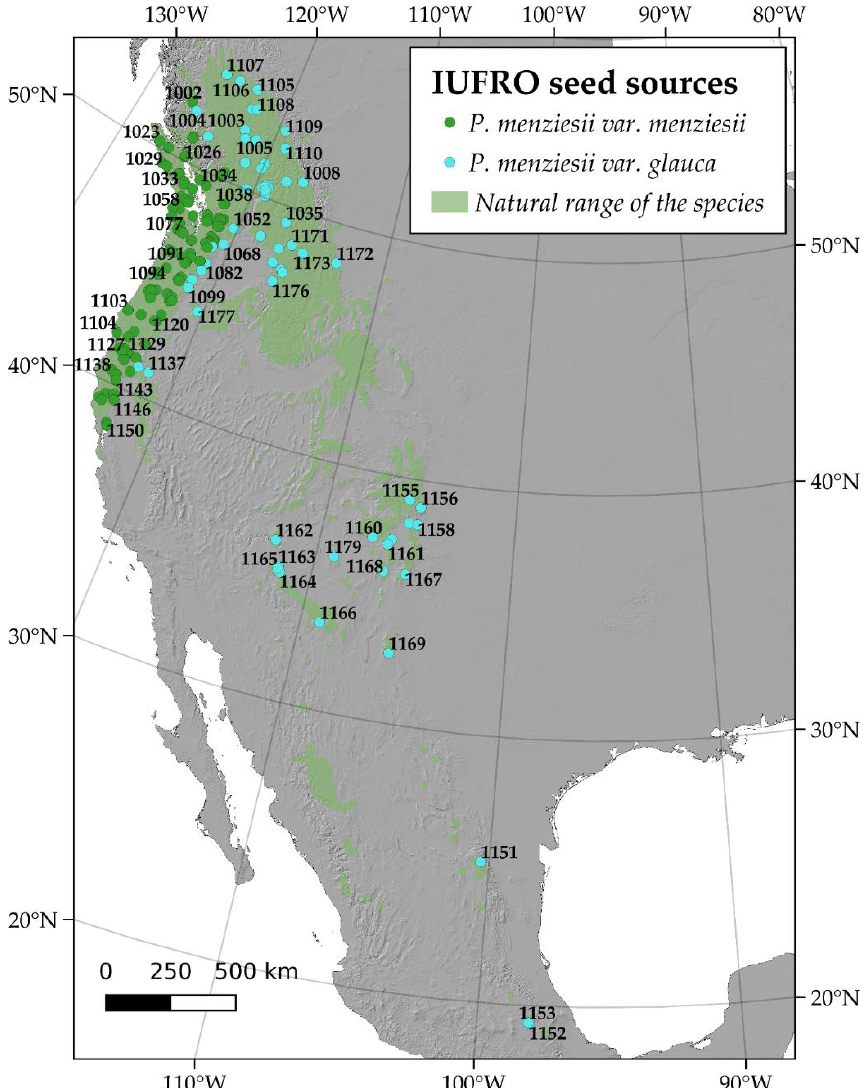
Figure 1. Spatial distribution of the 182 seed sources used by IUFRO for the extensive experimentation in Europe and provenances distributed to Italy and planted in the 2 IUFRO trials in Tuscany.